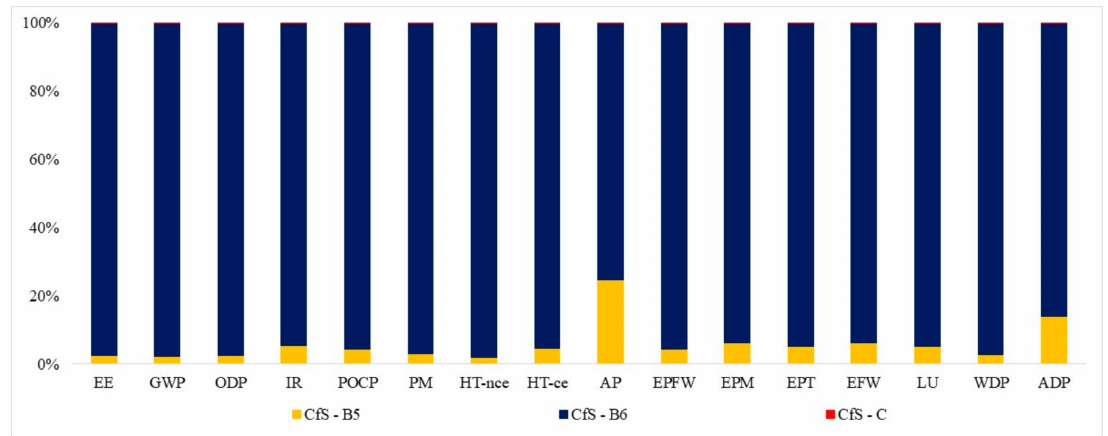
Figure A6. Contribution of the different phases to the life cycle impacts—CfS